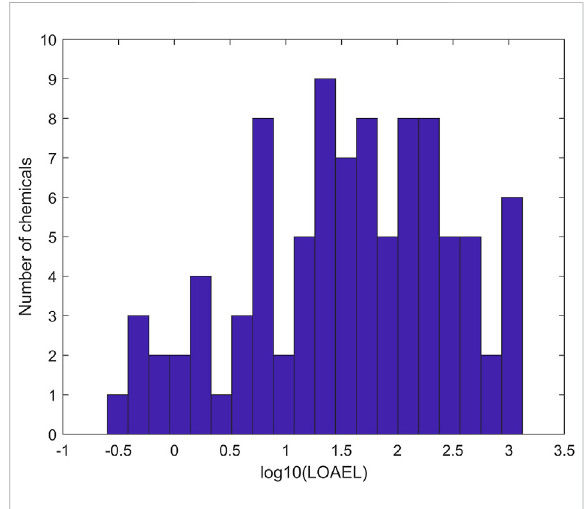
FIGURE 2 Distribution of positive chemicals in the training dataset at LOAEL (lowest observed adverse effect level) values. The x -axis indicates the log10 of LOAEL values. The y -axis gives the number of